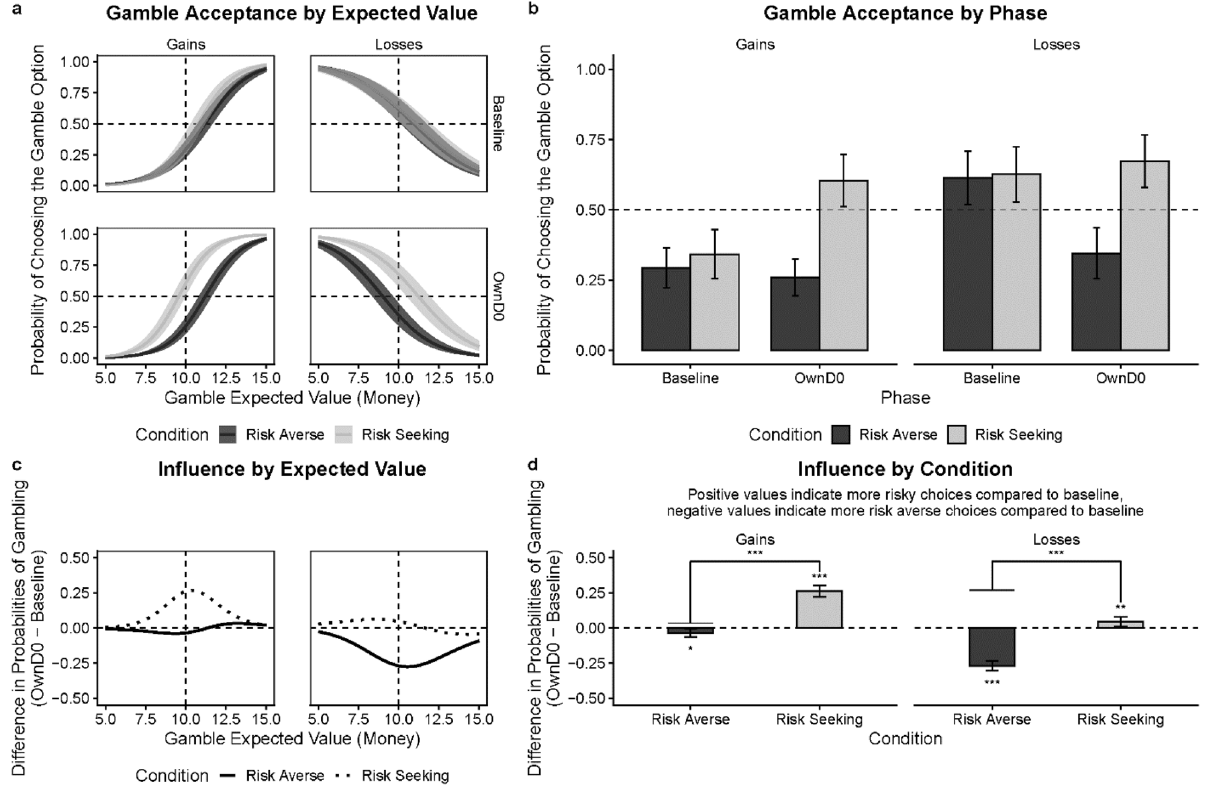
Figure 4. Conformity in the monetary domain. ( a ) Gamble probabilities as function of expected values in the gain or loss frame by norm conditions (i.e., risk-averse or risk-seeking ) in the baseline and OwnD0 (own choices) phases. Dashed lines represent equal expected values of the certain and gamble options (vertical), or the equal probability of opting to gamble or not (horizontal). ( b ) Marginal probabilities of accepting the gamble option across phases by conditions. ( c ) Amount of influence as a function of expected values for each condition in the gain or loss frame. ( d ) Marginal amount of influence for each norm condition in the gain or loss frame. The amount of influence is represented as the mean difference in gamble probability between OwnD0 and baseline phases. Hanging horizontal bars represent absolute magnitude of the difference. Results presented are based on individuals who completed the session on day 0 (D0). Error bars and confidence bands represent 95% Confidence Intervals (95% CI). * p < .05, ** p < .01, *** p <